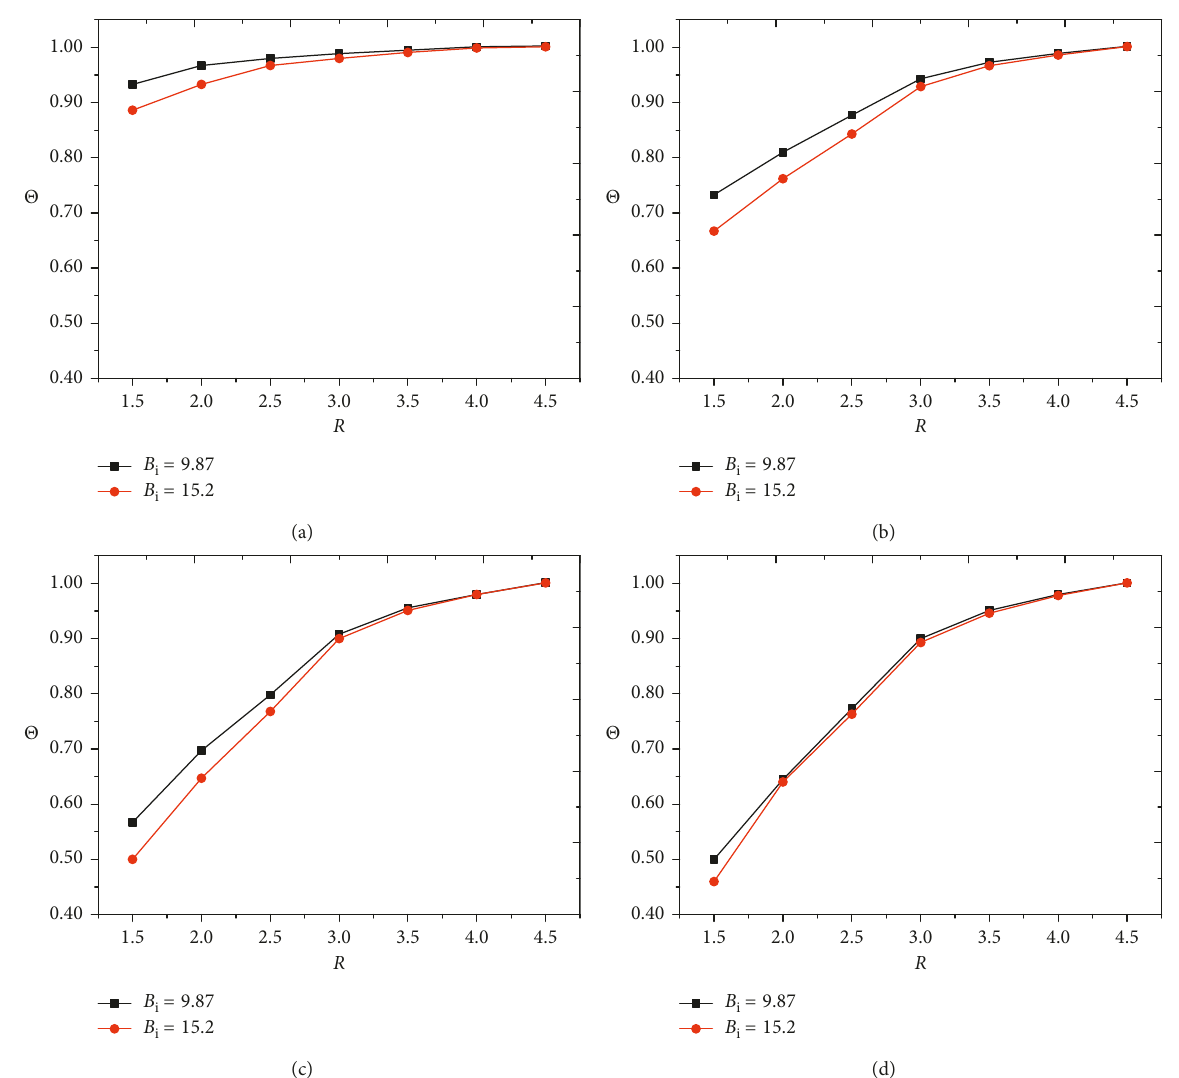
Figure 6: Effect of B